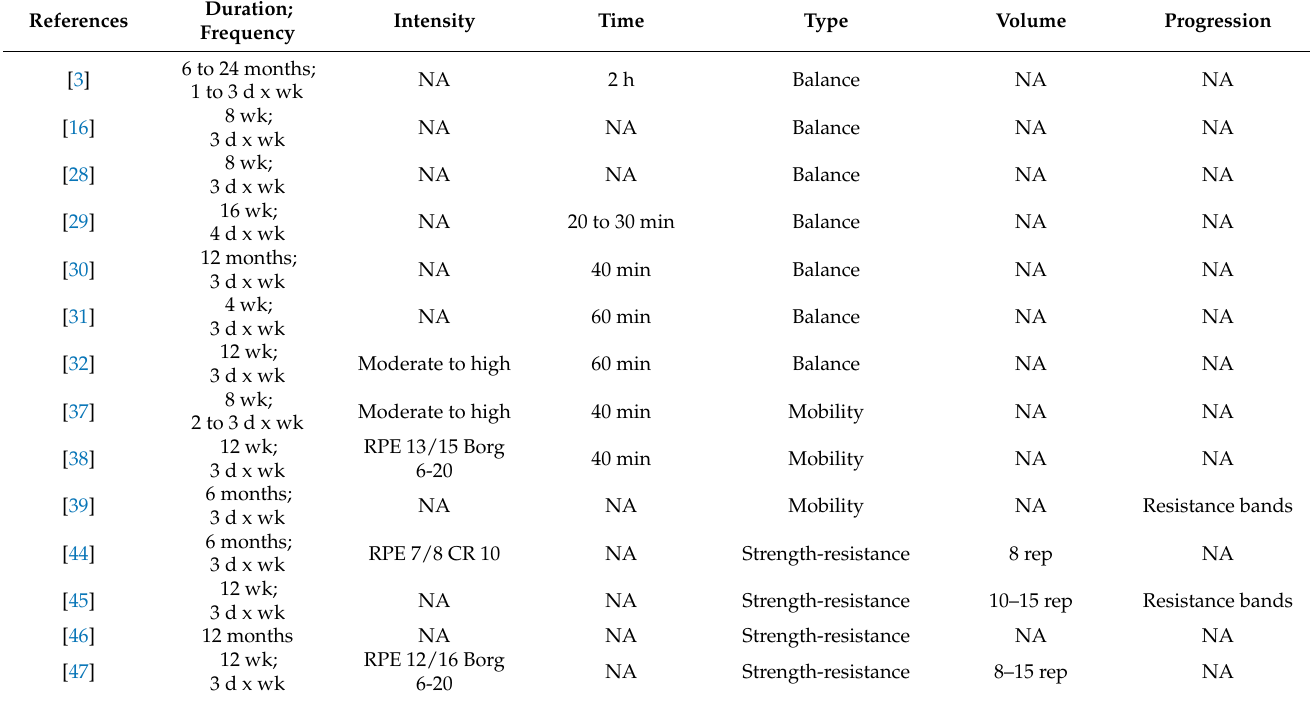
Table 1. The principles of exercise prescription before COVID-19.